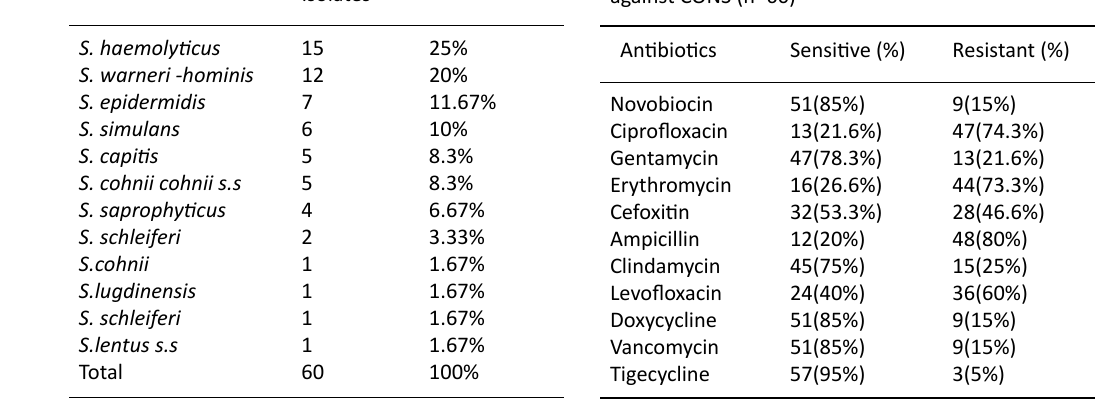
Table 4. Species Distribution of Coagulase Negative Staphylococcus isolates (n=60) Species/subspp. Table 5. In vitro activity of various antimicrobial agents